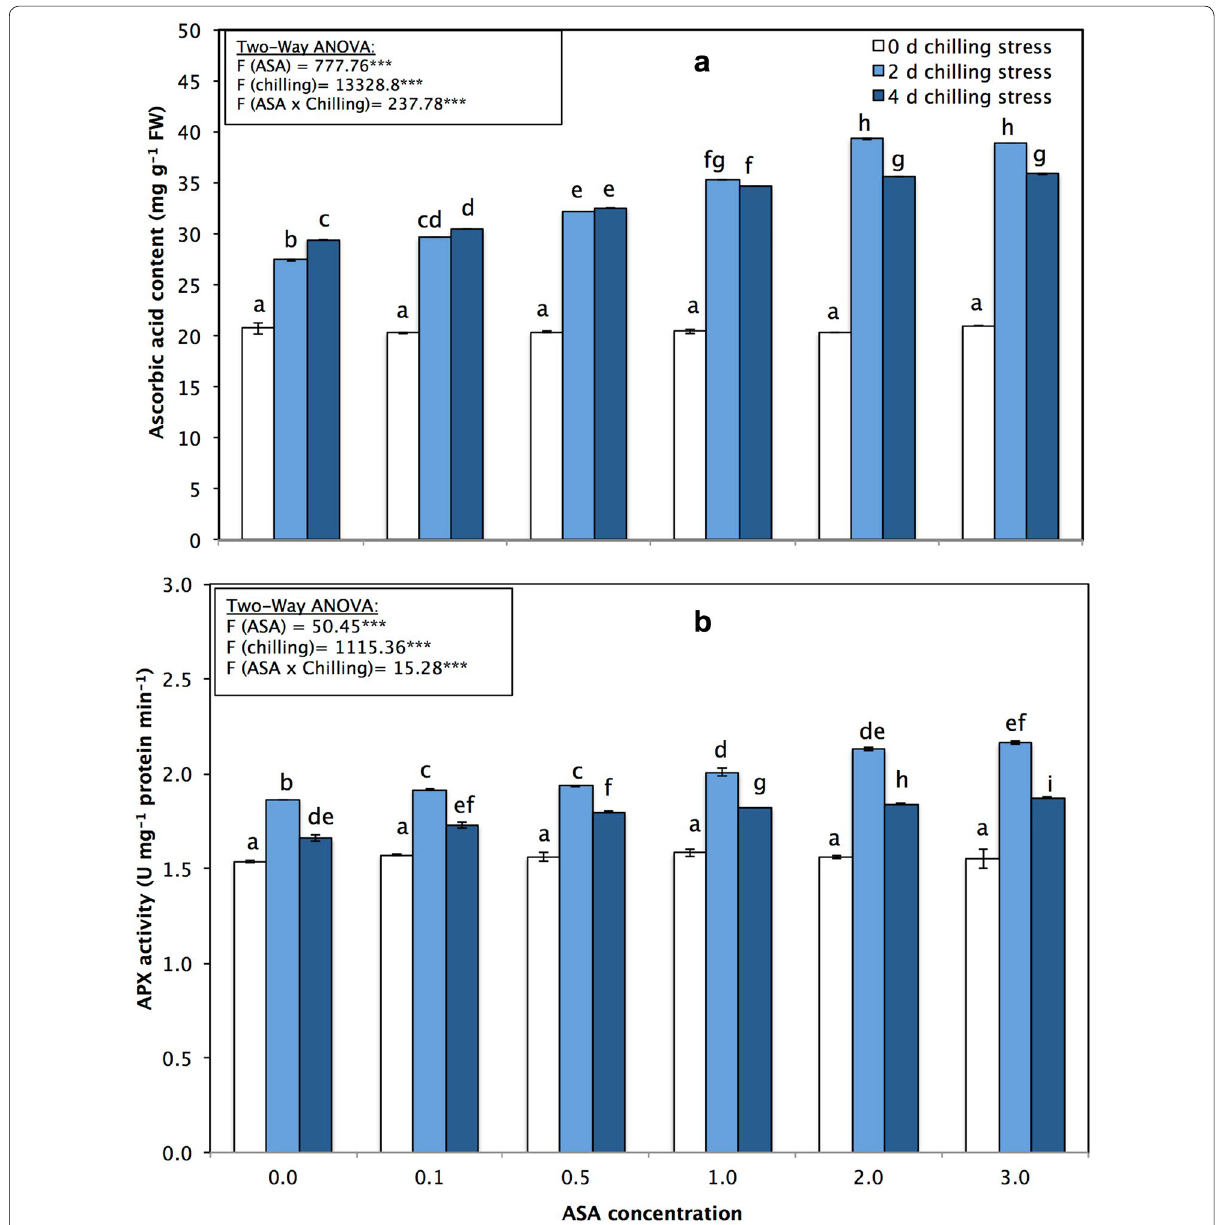
Fig. 4 a Ascorbic acid content (mg g − 1 FW) and b ascorbic peroxidase (APX; mmol ascorbate min − 1 g − 1 FW) in leaves of P. vulgaris L. after foliar application of different concentration of acetylsalicylic acid (ASA; 0, 0.1, 0.5, 1, 2, 3 mM) and exposed to different level of chilling stress (0, 2, 4 days). Data represented are mean of two replicates standard deviation. Variations between different chilling stresses and foliar ASA concentration were ± assessed by univariate analyses followed by post hoc analysis. Means with the same letters are not significantly different according to Duncan’s multiple